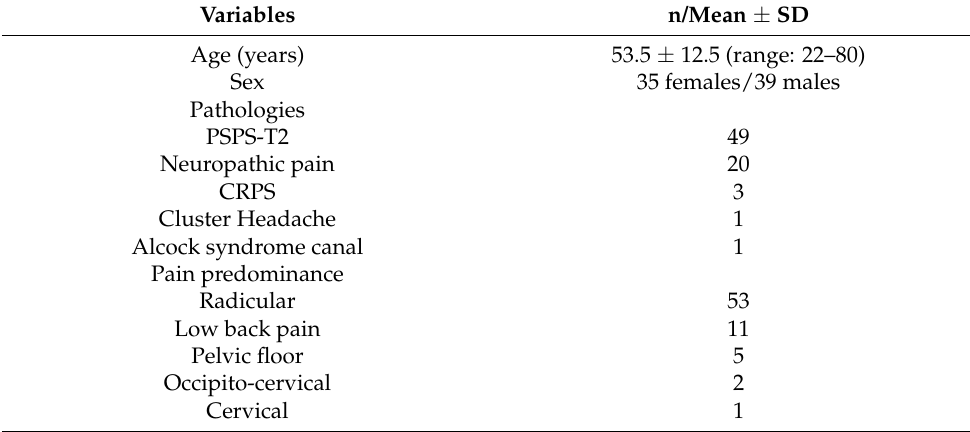
Table 1. Characteristics of